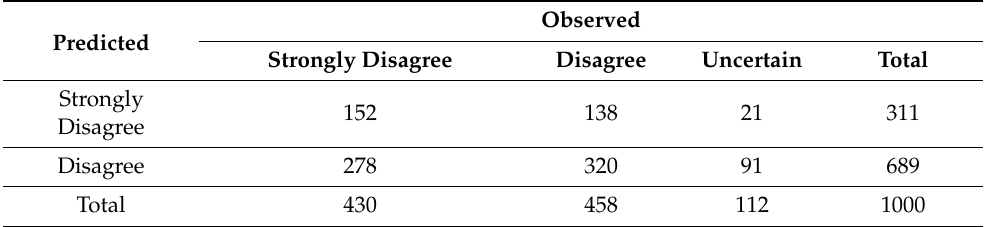
Table 6. Classification between observed and predicted cases of the Gender Equality